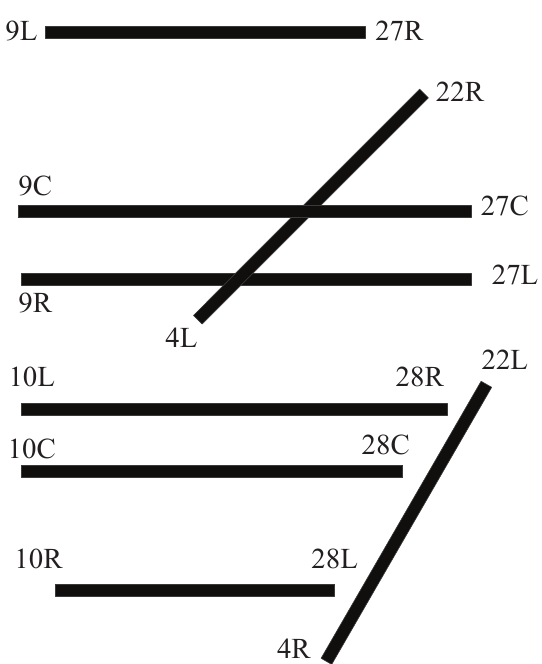
Figure 6. The runway configuration and orientation: O’Hare International Airport (Chicago). C,